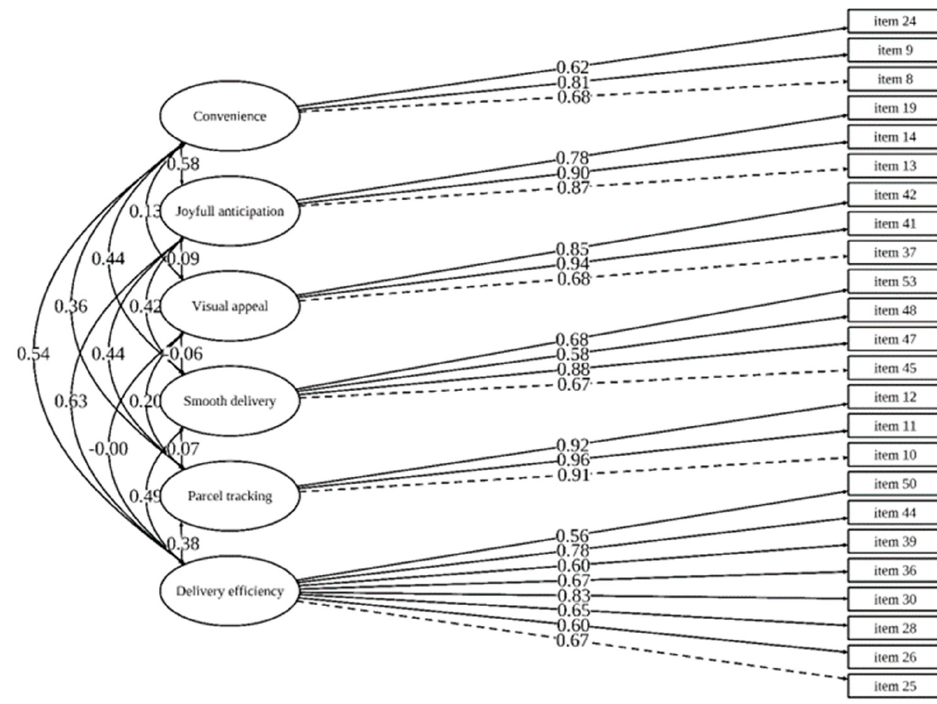
Figure 1. Standardized solution of the CFA model ( n = 454). Note. Error variances of the indicators are omitted for clarity. Table 4. Item statistics